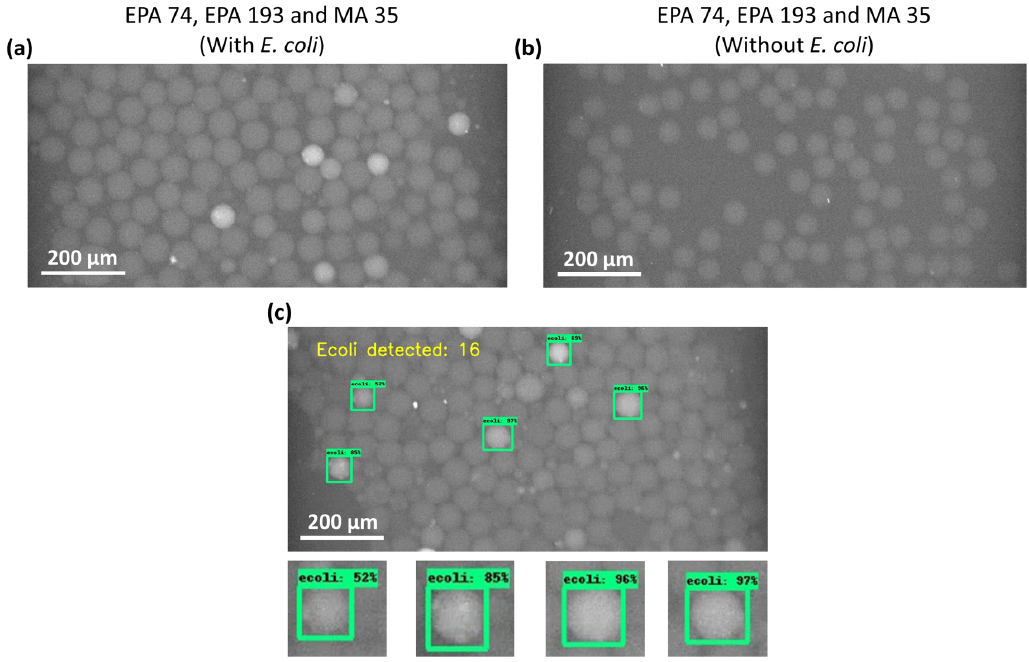
Figure 4. Specificity of the DNAzyme sensor. ( a ) Snapshot from the video obtained for the sample containing E. coli in the presence of other bacteria (( Serratia (EPA 74), Klebsiella (EPA 193), and Morganella (MA 35)). The approximate concentration (number of bacteria/mL) of each bacteria used was ∼ = 8 × 10 7 /mL. ( b ) Snapshot from the video obtained for the sample without E. coli in the presence of other bacteria (( Serratia (EPA 74), Klebsiella (EPA 193), and Morganella (MA 35)). ( c ) Counting of the fluorescent droplets using the algorithm developed in Python. The algorithm tags the fluorescent droplets with a unique ID, and counts the fluorescent